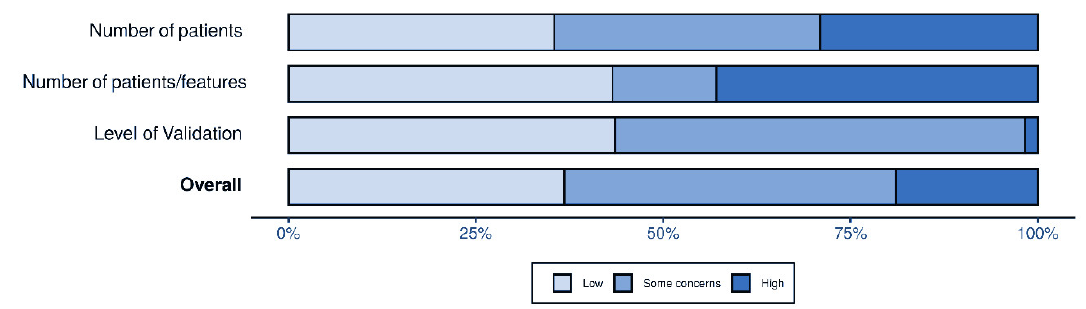
Figure 6. Per item and overall risk of bias.